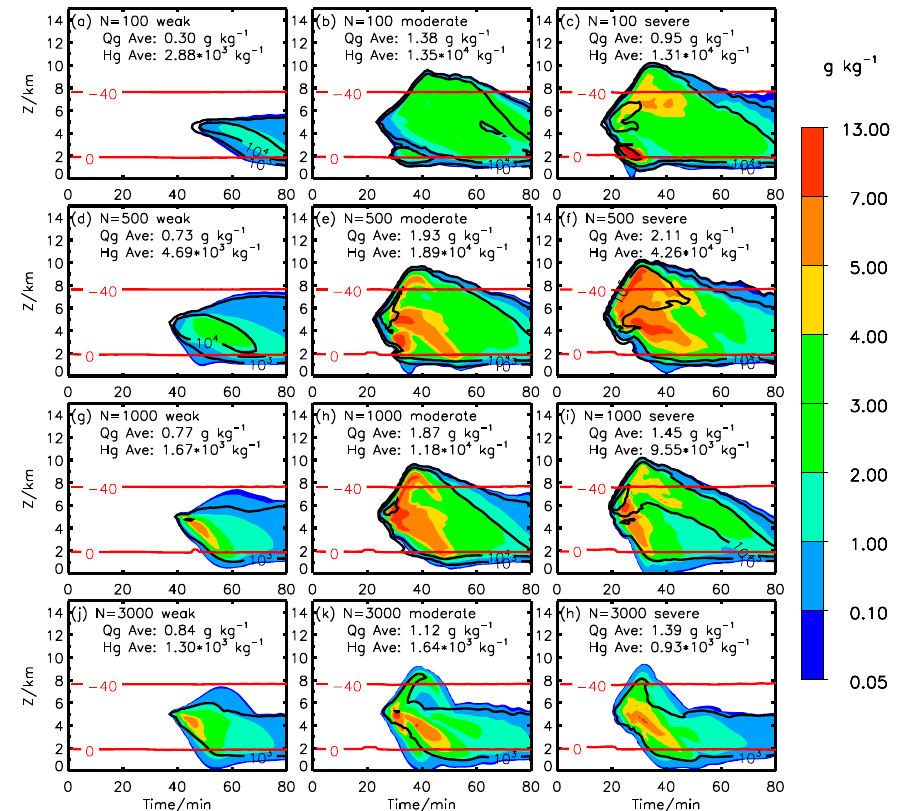
Figure 9. Spatial and temporal distribution of the mixing ratio and the number concentration of graupel for initial aerosol concentrations: ( a – c ) 100 cm − 3 , ( d – f ) 500 cm − 3 , ( g – i ) 1000 cm − 3 , ( j – l ) 3000 cm − 3 ; the red solid line represents the isotherm ( − 40 and 0 ◦ C); the black contour respectively represents: 10 3 , 10 4 , 10 5 , and 10 6 kg − 1 .